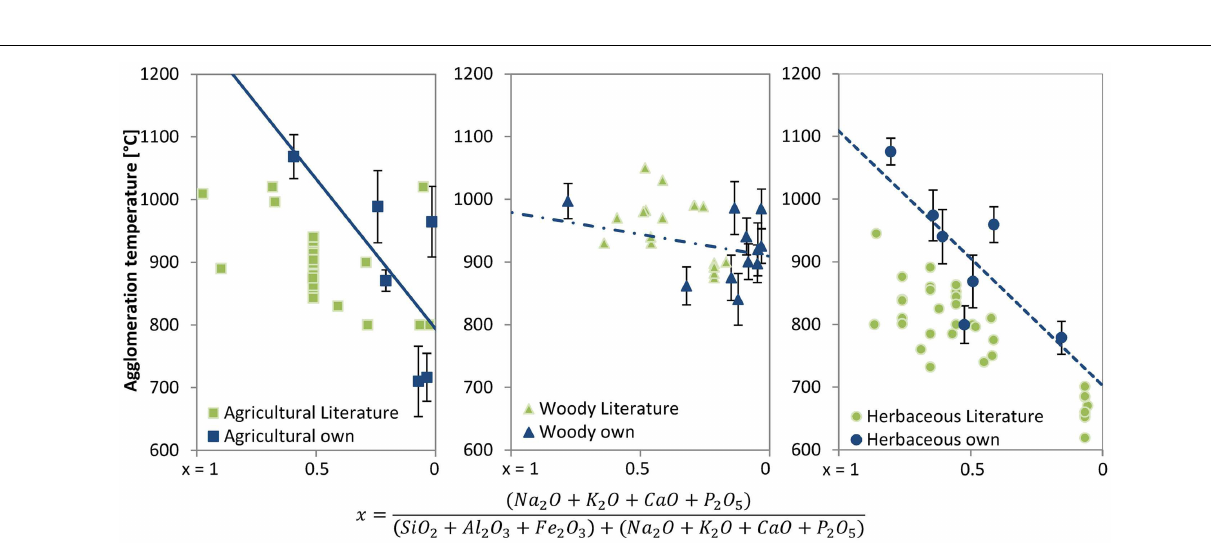
FIGURE 7 | Comparison of our own (interpolated to d s = 225 µ m; X a = 0.1kg/kg; u / u 0 = 4) results with original test runs published in literature (as listed inTable S2 in Supplementary Material)